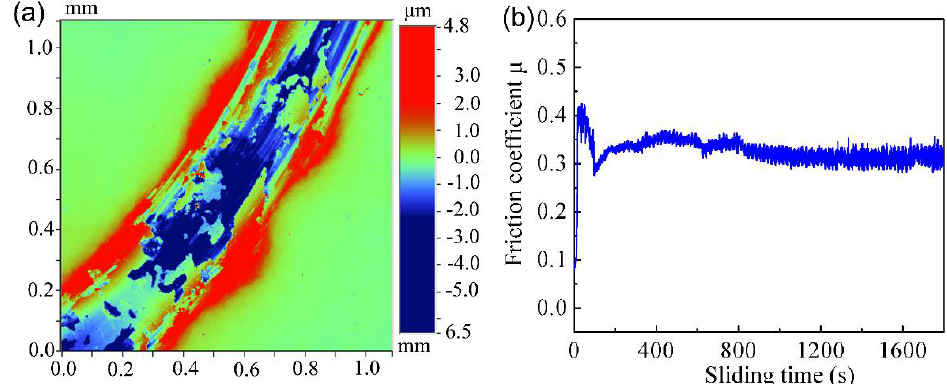
Figure 12. Surface topography of the worn track and the corresponding friction coefficient of C17200 copper alloy: ( a ) surface topography and ( b ) friction coefficient.